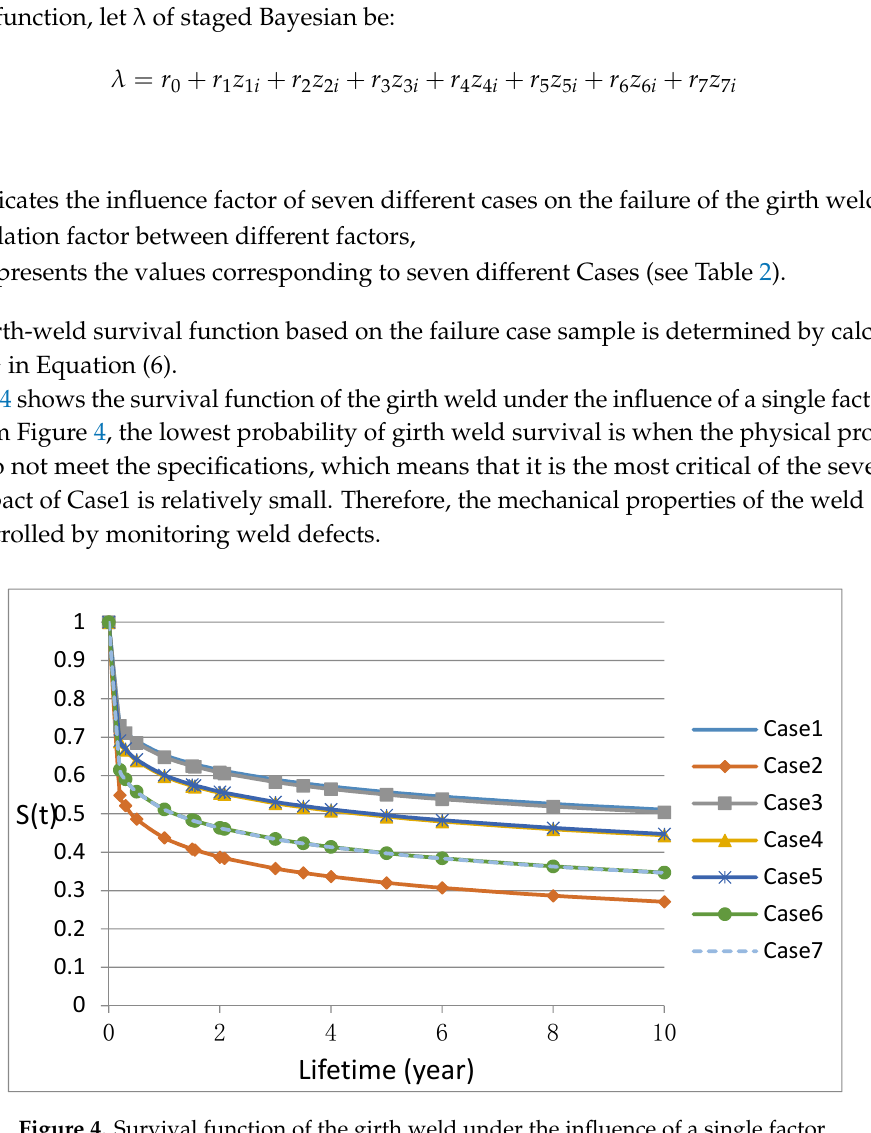
Figure 4. Survival function of the girth weld under the influence of a single factor.